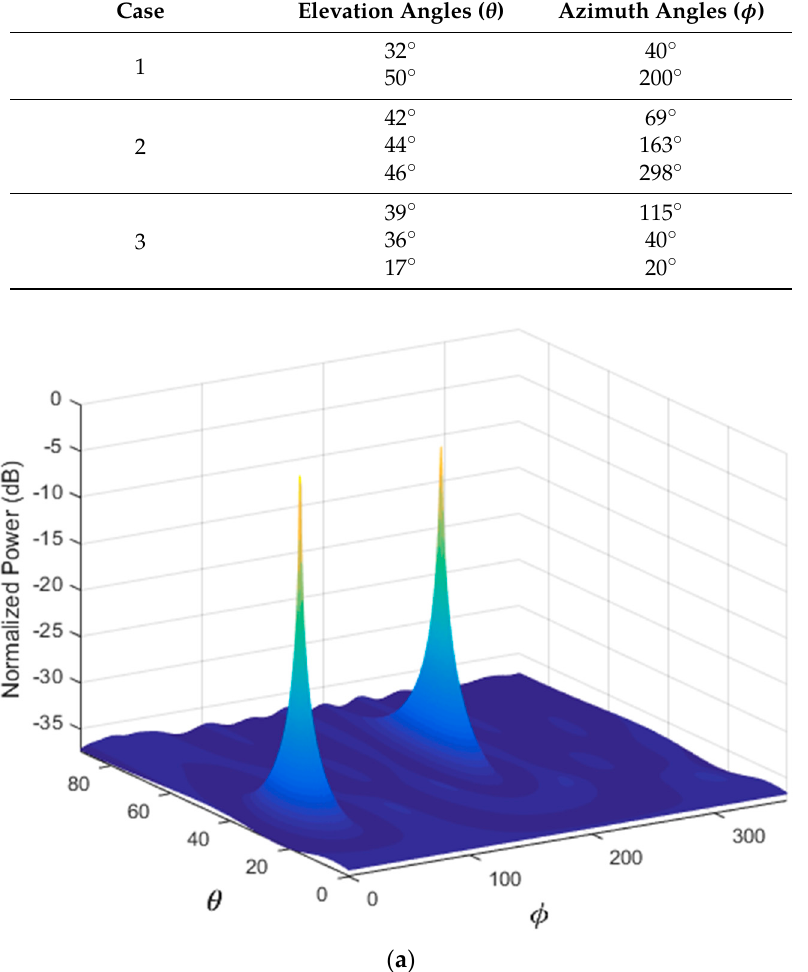
( b ) Figure 4. Performance estimation of the PDDA method with two AOAs. ( a ) 3D plot of the PDDA method; ( b ) 2D plot of the PDDA method.